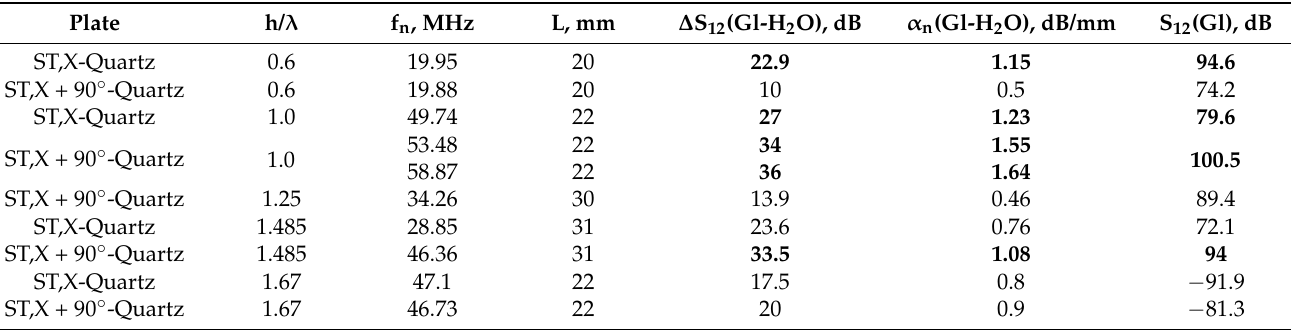
Table 4. Acoustic plate modes with largest responses towards viscosity measured in different quartz plates at 20 ◦